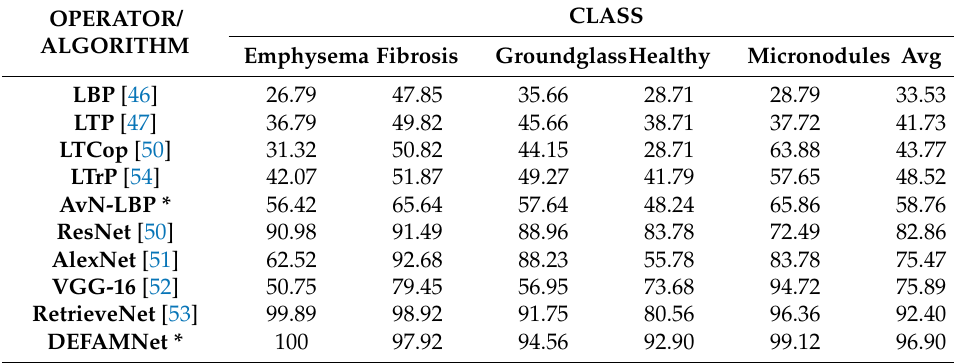
Table 5. Retrieval Accuracy (ARP) in percentage on ILD database.